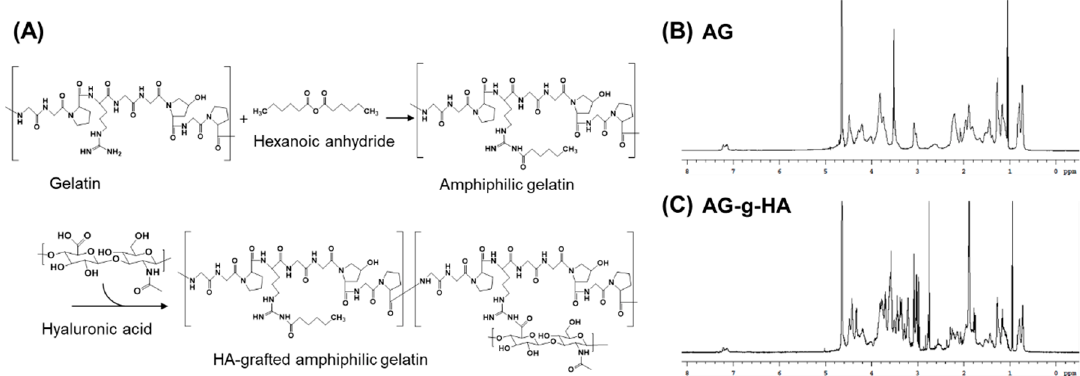
Figure 2. ( A ) The reaction scheme for the synthesis of hyaluronic acid-grafted amphiphilic gelatin (AG-g-HA); 1 H NMR spectrum of macromolecules in D2O for ( B ) amphiphilic gelatin (AG) and ( C ) AG-g-HA. As shown, the NMR spectra at 3.5, 1.2, 1.9 and around 3.5 ppm demonstrated the successful synthesis of AG-g-HA.